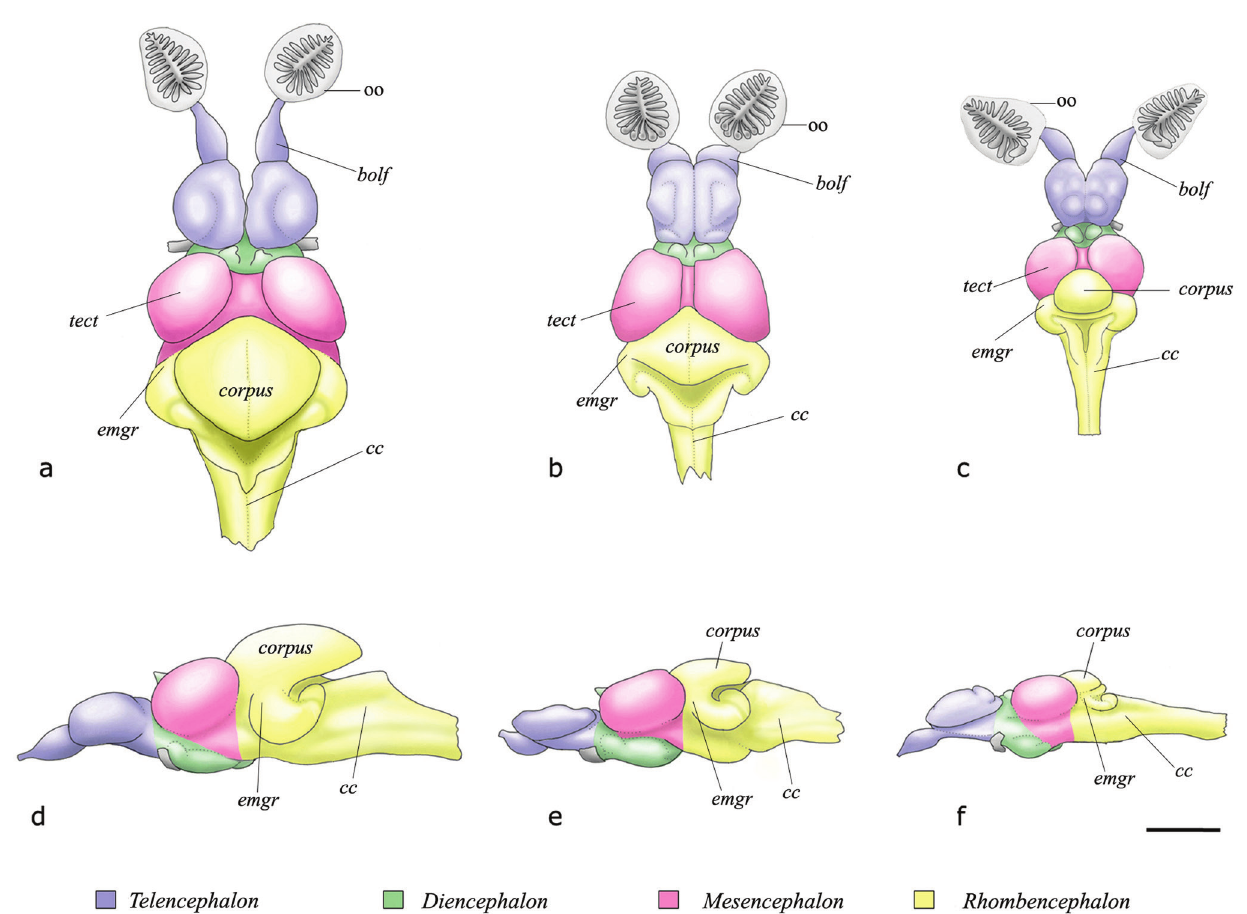
Fig. 3. Brain in dorsal and left views: a, d) Gymnotocinclus anosteos , UFRGS 11296, female, 39.8 mm SL. b, e) Hisonotus notatus , DZSJRP 13852, female, 27.4 mm SL. c, f) Otothyris lophophanes , DZSJRP 13069, female, 26.3 mm SL. Abbreviations: bolf , bulbus olfactorius ; cc , crista cerebellaris ; corpus , corpus cerebelli ; emgr , eminentia granularis ; oo, olfactory organ; tect , tectum mesencephali . Scale bar = 1mm. Left view does not include olfactory